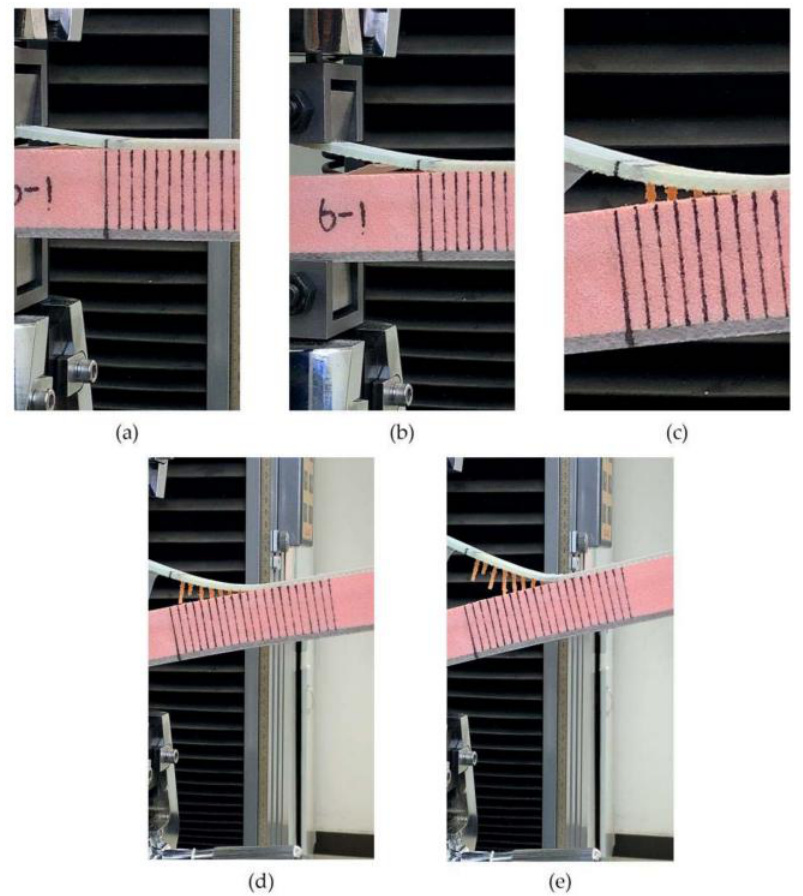
Figure 15. The crack propagation process in the sutured specimen. ( a ) Crack initiation. ( b ) Interface opening. ( c ) The leading edge resin column was pulled out or broken. ( d ) Interface opening. ( e ) The rear resin column was pulled out or